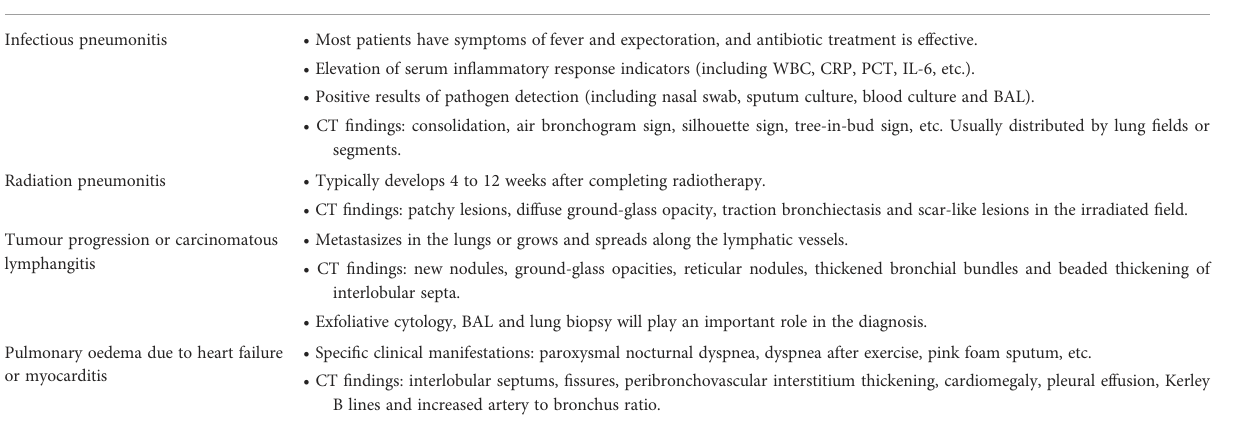
TABLE 3 Differential diagnosis of immune checkpoint inhibitor-related pneumonitis. Differential diagnosis Description Infectious pneumonitis (cid:129) Most patients have symptoms of fever and expectoration, and antibiotic treatment is effective. (cid:129) Elevation of serum in fl ammatory response indicators (including WBC, CRP, PCT, IL-6, etc.). (cid:129) Positive results of pathogen detection (including nasal swab, sputum culture, blood culture and BAL). (cid:129) CT fi ndings: consolidation, air bronchogram sign, silhouette sign, tree-in-bud sign, etc. Usually distributed by lung fi elds or segments. Radiation pneumonitis (cid:129) Typically develops 4 to 12 weeks after completing radiotherapy. (cid:129) CT fi ndings: patchy lesions, diffuse ground-glass opacity, traction bronchiectasis and scar-like lesions in the irradiated fi eld. (cid:129) Metastasizes in the lungs or grows and spreads along the lymphatic vessels. Tumour progression or carcinomatous lymphangitis (cid:129) CT fi ndings: new nodules, ground-glass opacities, reticular nodules, thickened bronchial bundles and beaded thickening of interlobular septa. (cid:129) Exfoliative cytology, BAL and lung biopsy will play an important role in the diagnosis. Pulmonary oedema due to heart failure or myocarditis